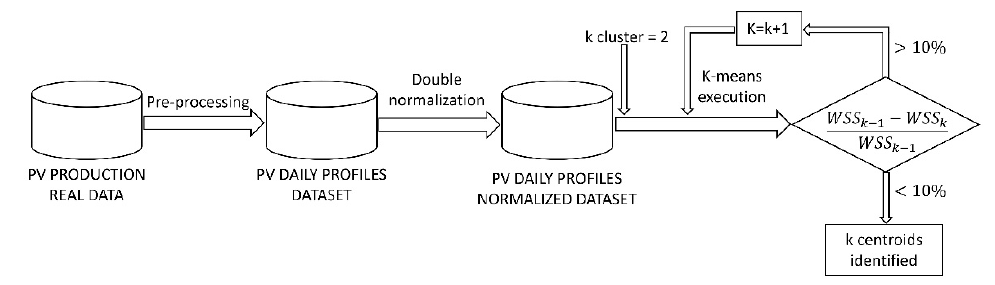
Figure 2. PV production profiles clustering flowchart of the procedure adopted.